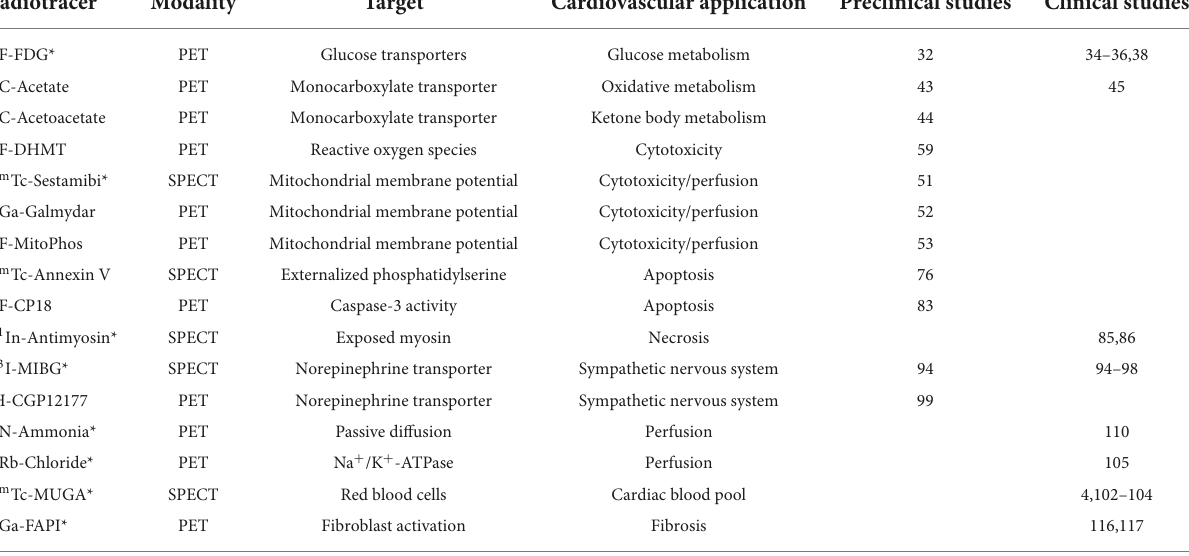
TABLE 1 Radiotracer, mechanism of uptake, and application for nuclear imaging of anthracycline-induced cardiotoxicity.